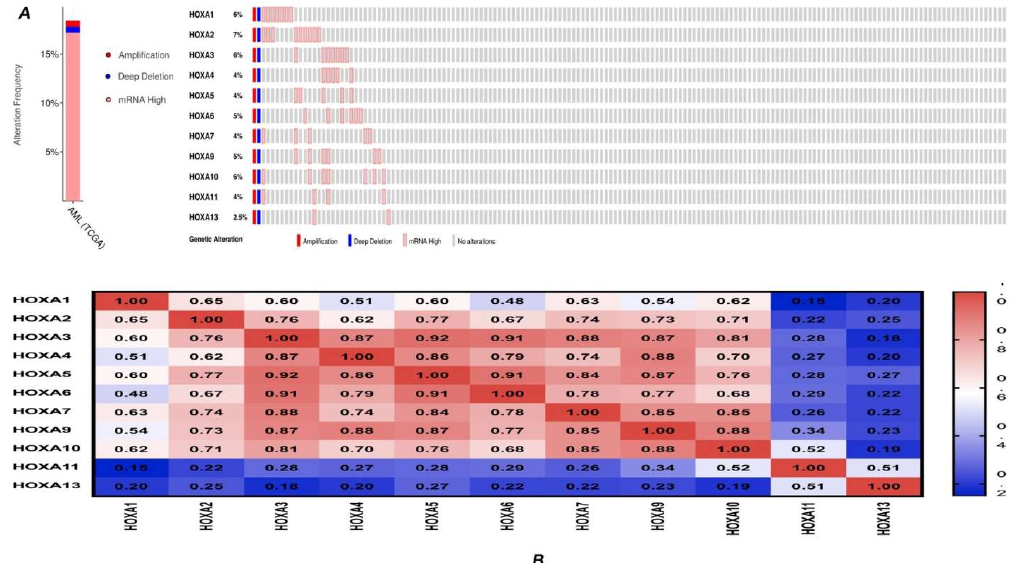
Figure 4. Genetic alteration and correlations of HOXA genes in AML. ( A ) Genetic alteration of HOXA genes in AML. ( B ) Genetic correlations of HOXA genes in